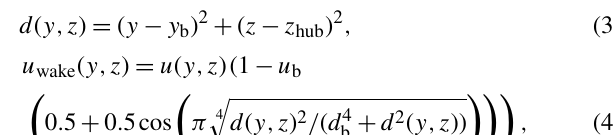
Table 1. Signals stored in the load